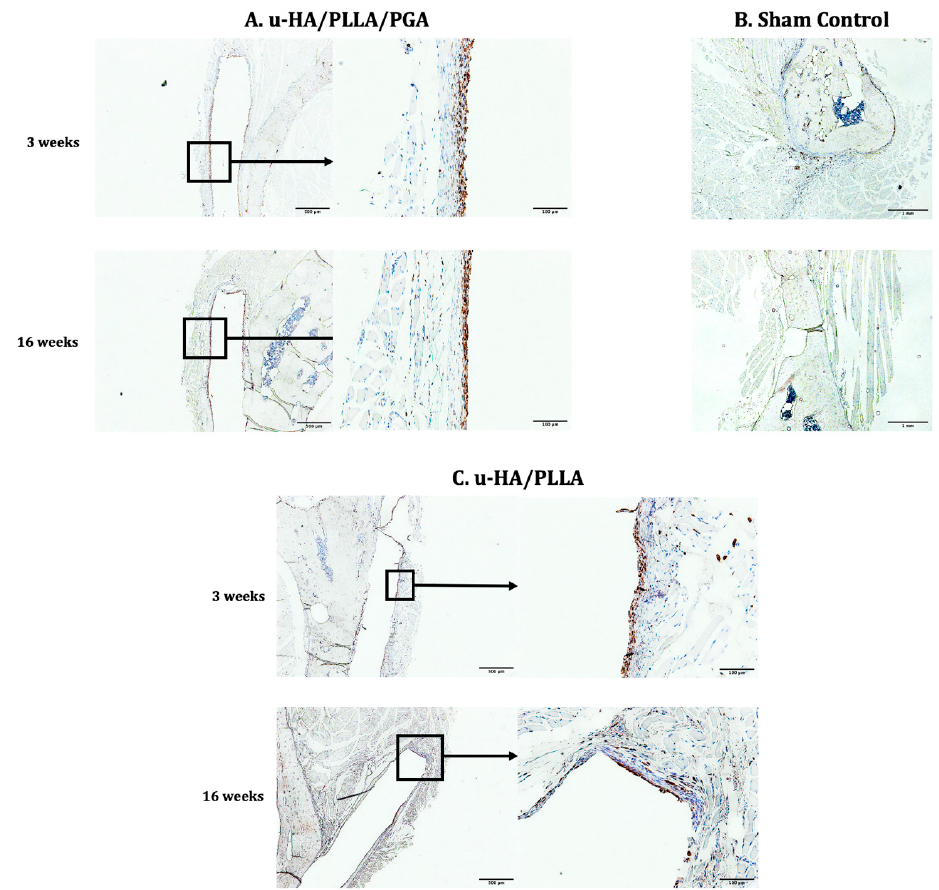
Figure 14. CD68 expression in the u-HA/PLLA/PGA subgroup, u-HA/PLLA subgroup, and sham control. Images in each subgroup were taken at 4× and 20× magnification (from left to right). Images of the sham control group were taken at 1.25× magnification. ( A ) u-HA/PLLA/PGA subgroup. ( B ) Sham control group. ( C ) u-HA/PLLA subgroup. Scale bar: 1 mm (1.25× magnification image), 500 μ m (4× magnification image), and 100 μ m (20× magnification image). The results of the labeling index indicated no differences between the two subgroups at each time point or between the two time points within each material subgroup. However, the index was significantly lower at Week 16 than Week 3 in both subgroups (Figure 15).